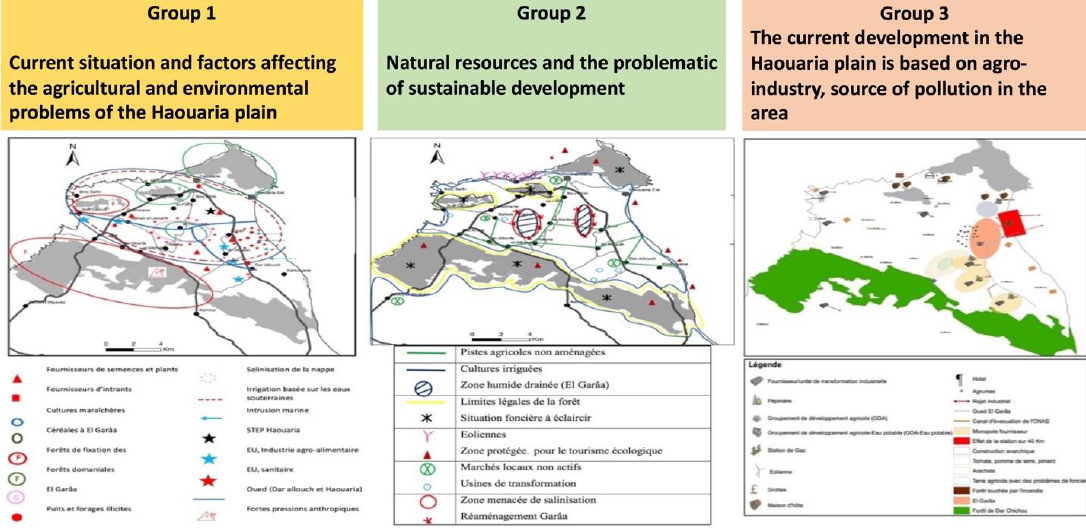
Figure 5. Local stakeholders’ perception and representation of the territorial dynamics in the Haouaria plain (three groups).